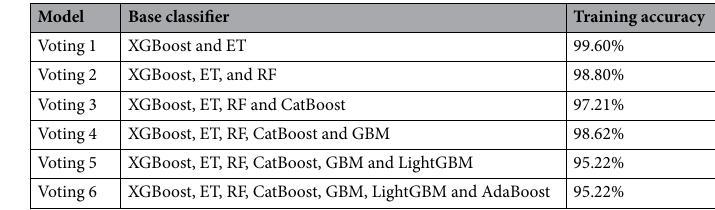
Table 7. The voting ensemble model.